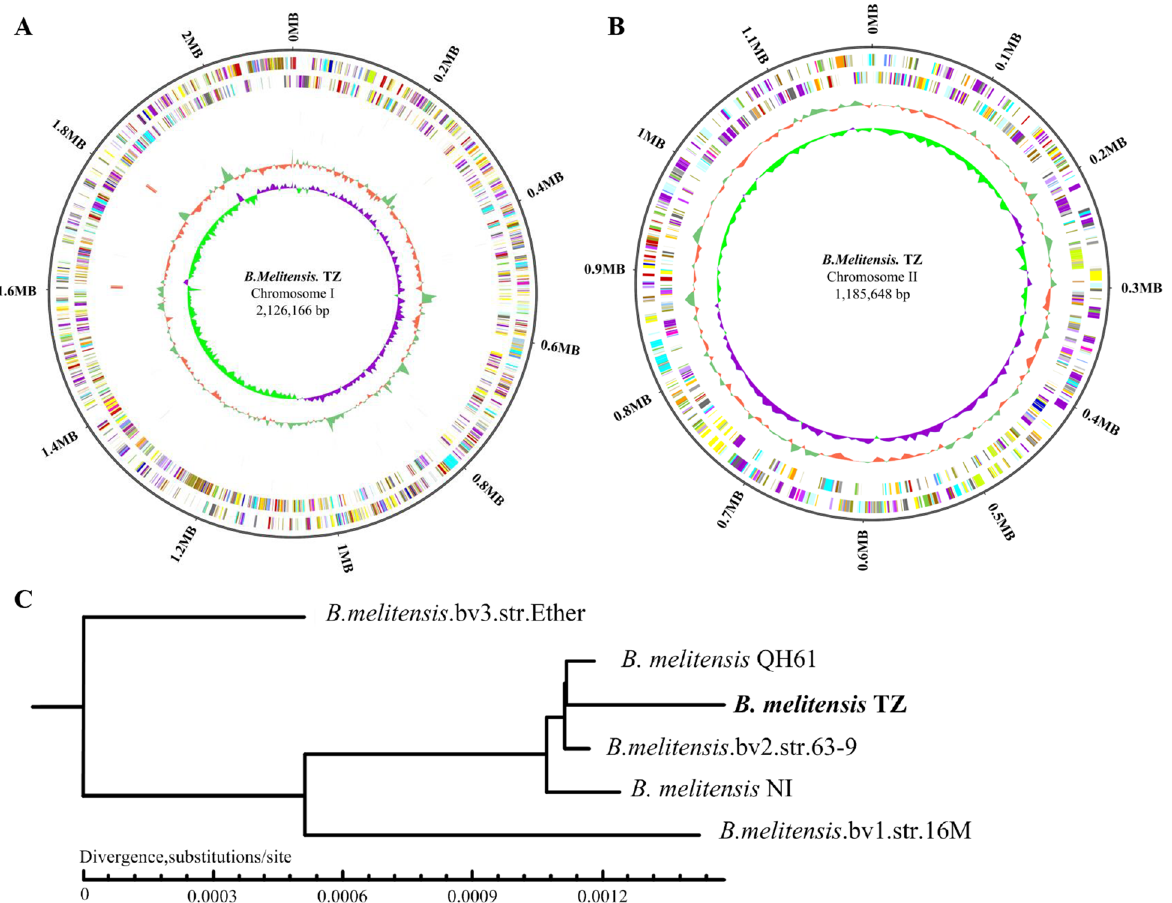
Fig. 4 Circular representation of the whole-genome sequencing of the B. melitensis TZ strain isolate. A Chromosome I of B. melitensis TZ. From outer to inner: genome size, forward strand gene, reverse strand gene, forward strand ncRNA, reverse strand ncRNA, repeat, GC and GC-SKEW. B Chromosome II of B. melitensis TZ. From outer to inner: genome, size, forward strand gene, reverse strand gene, GC and GC-SKEW. The detailed genome size is numbered outside of the circle. Color refers to the cluster of orthologous groups (COG) classification. C Phylogenetic tree of the B. melitensis TZ strain and reference